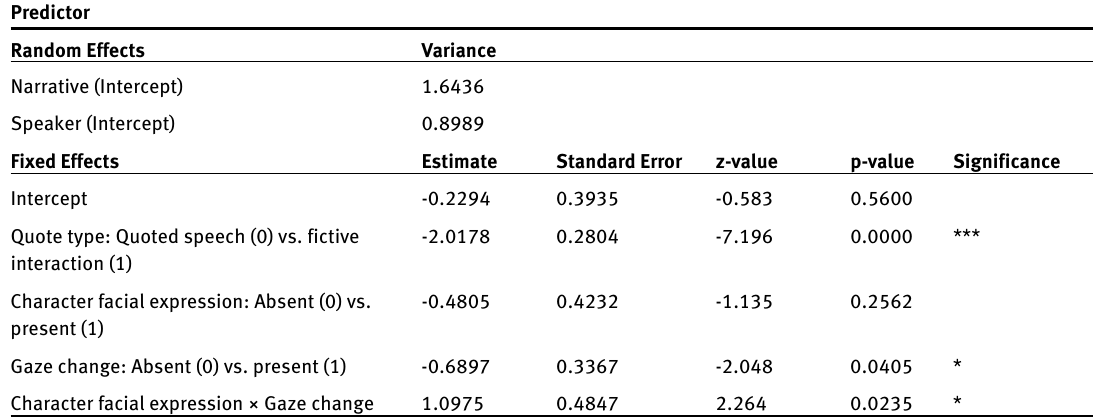
Table 6: The best generalized mixed-effects regression model for Quoted Dialogues in the entire dataset. Only predictors for the best-fit model are shown. Negative estimates indicate lower probability. Significance is indicated as follows: ***